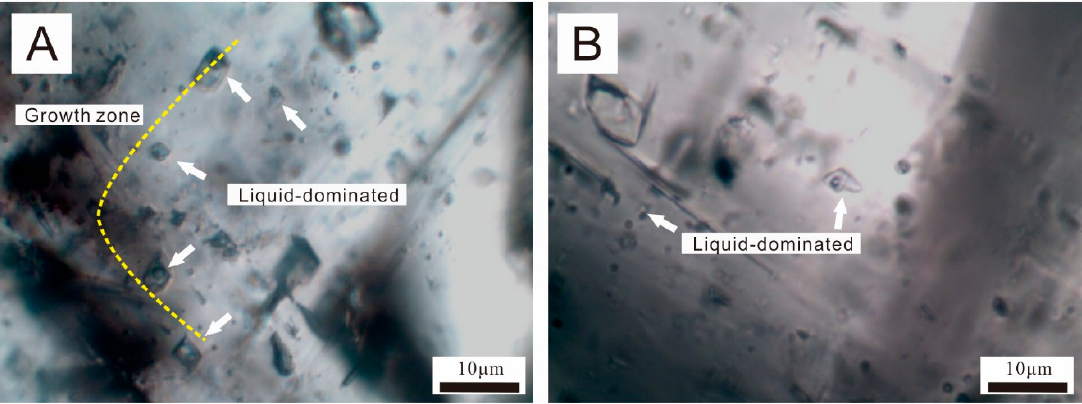
Figure 9. Photomicrographs showing fluid inclusion petrography. ( A ) Liquid-dominated fluid inclusions outlined the growth zone of Cd dolomite (Xinjigu; P 2 q ); ( B ) liquid-dominated fluid inclusions in random populations were distributed evenly in a crystal without special orientation (4989.6 m; Well Hanshen1; P 2 q ).